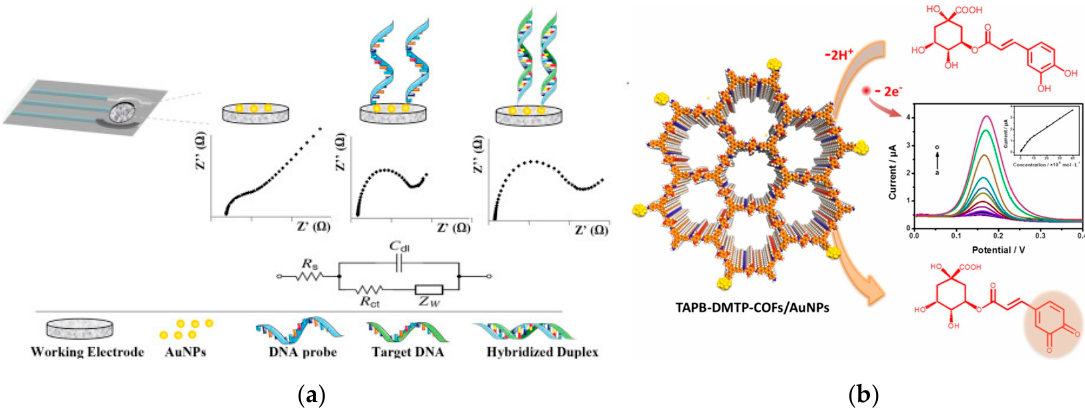
Figure 10. Electrochemical sensor based on AuNPs. ( a ) DNA hybridization sensor based on AuNP- modified SPCE for nucleic acid detection. Reproduced with permission from [153]. Copyright